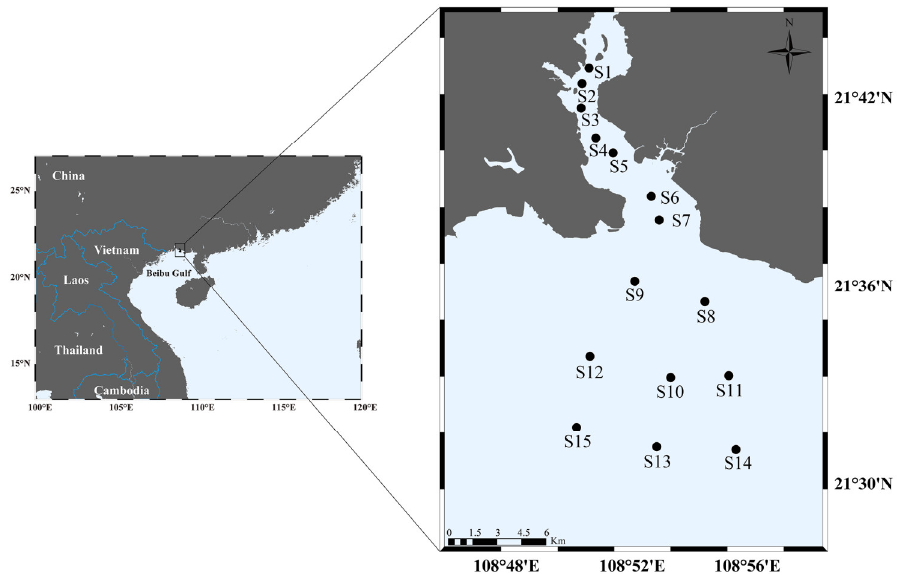
Figure 1. Location of the sampling sites in the Dafengjiang River estuary.